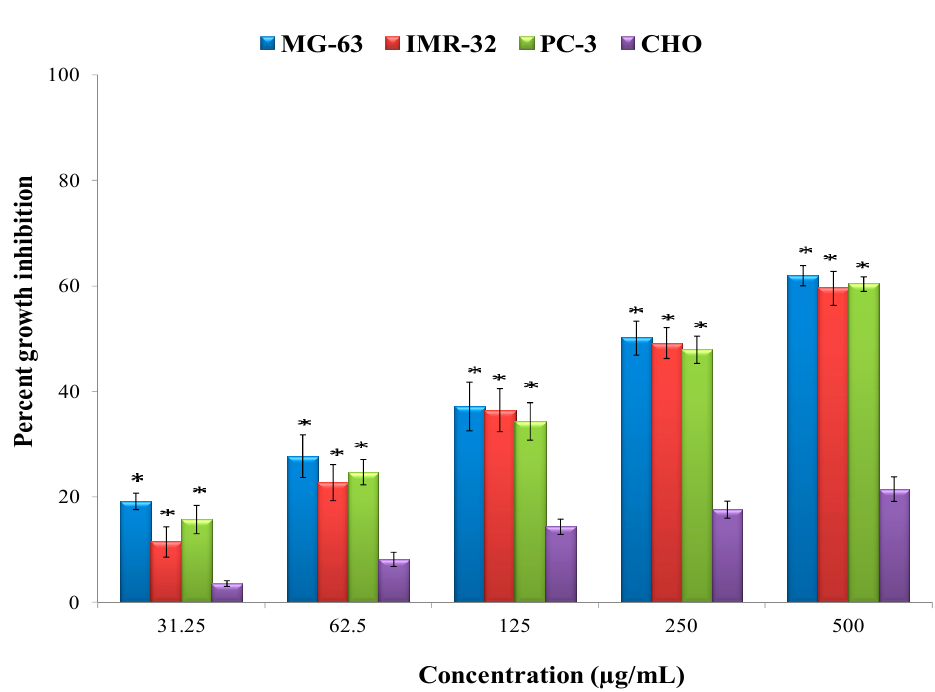
Figure 8. Antiproliferative activity of the CaLE fraction from C. fistula on different cell lines in the MTT (3-(4,5-dimethylthiazol-2-yl)-2,5-diphenyltetrazolium bromide) assay ( n = 60). * indicates a statistically significant difference at ( p ≤ 0.05).